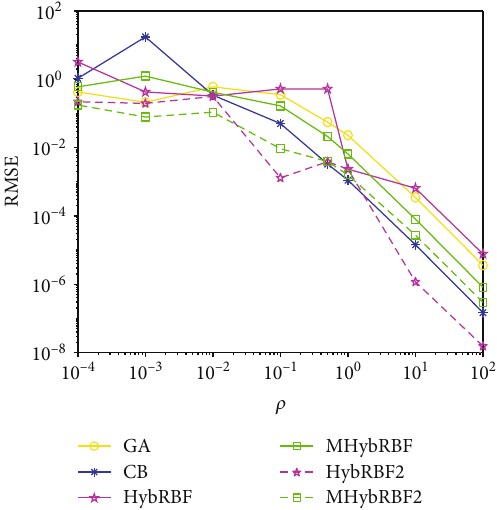
Figure 3: The comparison of RMSE of GA, CB, HybRBF, MHybRBF, HybRBF2, and MHybRBF2 with di ff erent ρ